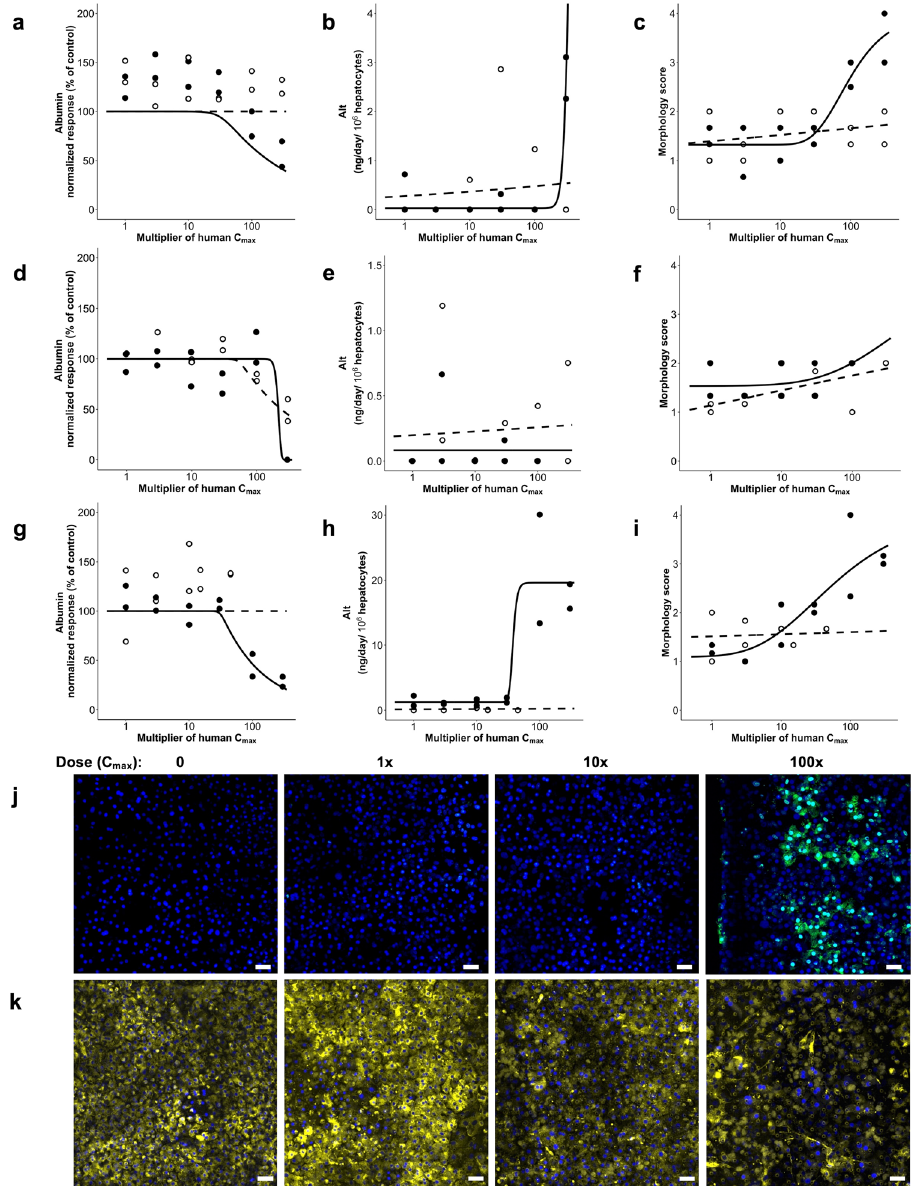
Fig. 4 Detection of drug concentration-dependent toxicity and liver injury. Effect of Cloazpine (closed circles) or olanzapine (open circles) on albumin production ( a ), ALT release ( b ), and morphology score ( c ); Effect of troglitazone (closed circles) or pioglitazone (open circles) on albumin production ( d ), ALT release ( e ), and morphology score ( f ); Effect of trova fl oxacin (closed circles) or levo fl oxacin (open circles) on albumin production ( g ), ALT release ( h ) and morphology score ( i ); Immuno fl uorescence microscopic images showing concentration-dependent increases in caspase 3/7 staining (green;) indicative of apoptosis after treatment with trova fl oxacin at 0,1, 10, and 100 ( j ) times the unbound human C max for 7 days; concentration-dependent decrease in TMRM staining (yellow) indicative of mitotoxicity in response to treatment with sitaxsentan at 0,1,10, and 100 ( k ) times the unbound human C max for 7 days. Scale bar represents 50 µ